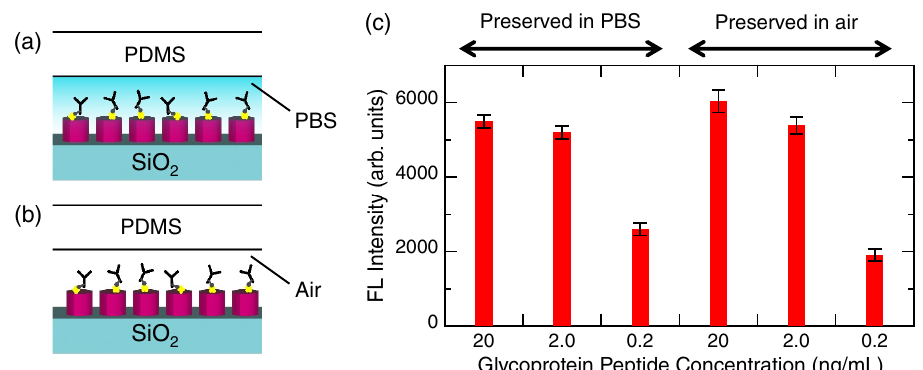
Figure 4. Test for precoating of the capture Abs. ( a ) Precoated Abs were kept in PBS for ∼ 20 h. ( b ) Precoated Ab was kept in air and dried for ∼ 20 h. ( c ) After a short runtime of the target glycopro- tein peptide and the FL-labeled detection Ab, the detected FL intensities are shown using red bars with error bars in the two cases ( a , b